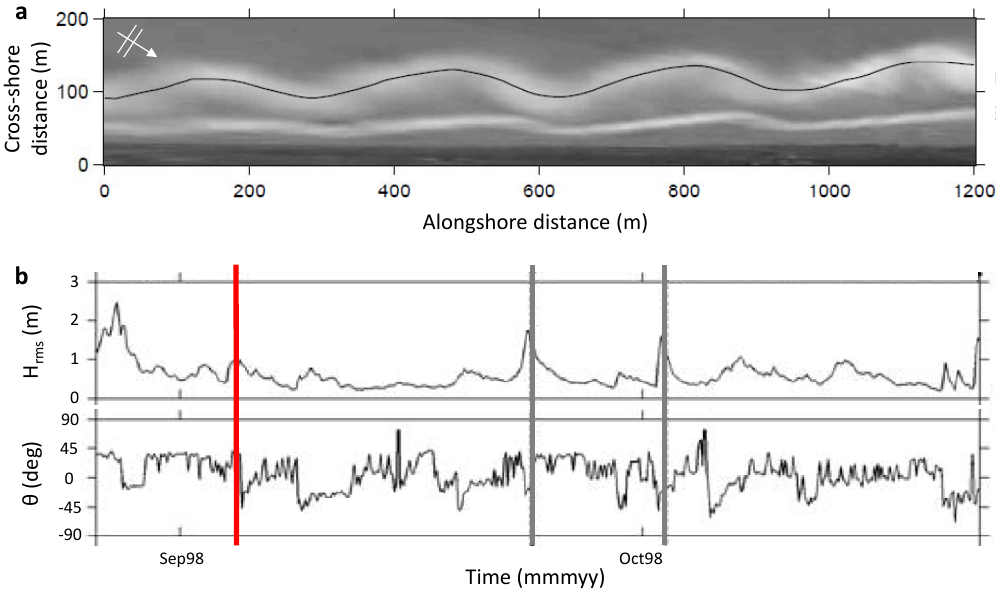
Figure 9. Example of the Idt coupling type observed at Duck, NC, USA. The video image in (a) is from 4 September 1998, indicated by the solid red line in the time series in (b) , showing the offshore root-mean-square wave height H rms (top) and angle of wave incidence with respect to shore normal θ (bottom). The solid grey lines correspond to moments when an existing crescentic pattern was wiped out, see Van Enckevort et al. (2004). Adapted from Van Enckevort and Ruessink (2003) (a) and Van Enckevort et al. (2004) (b)